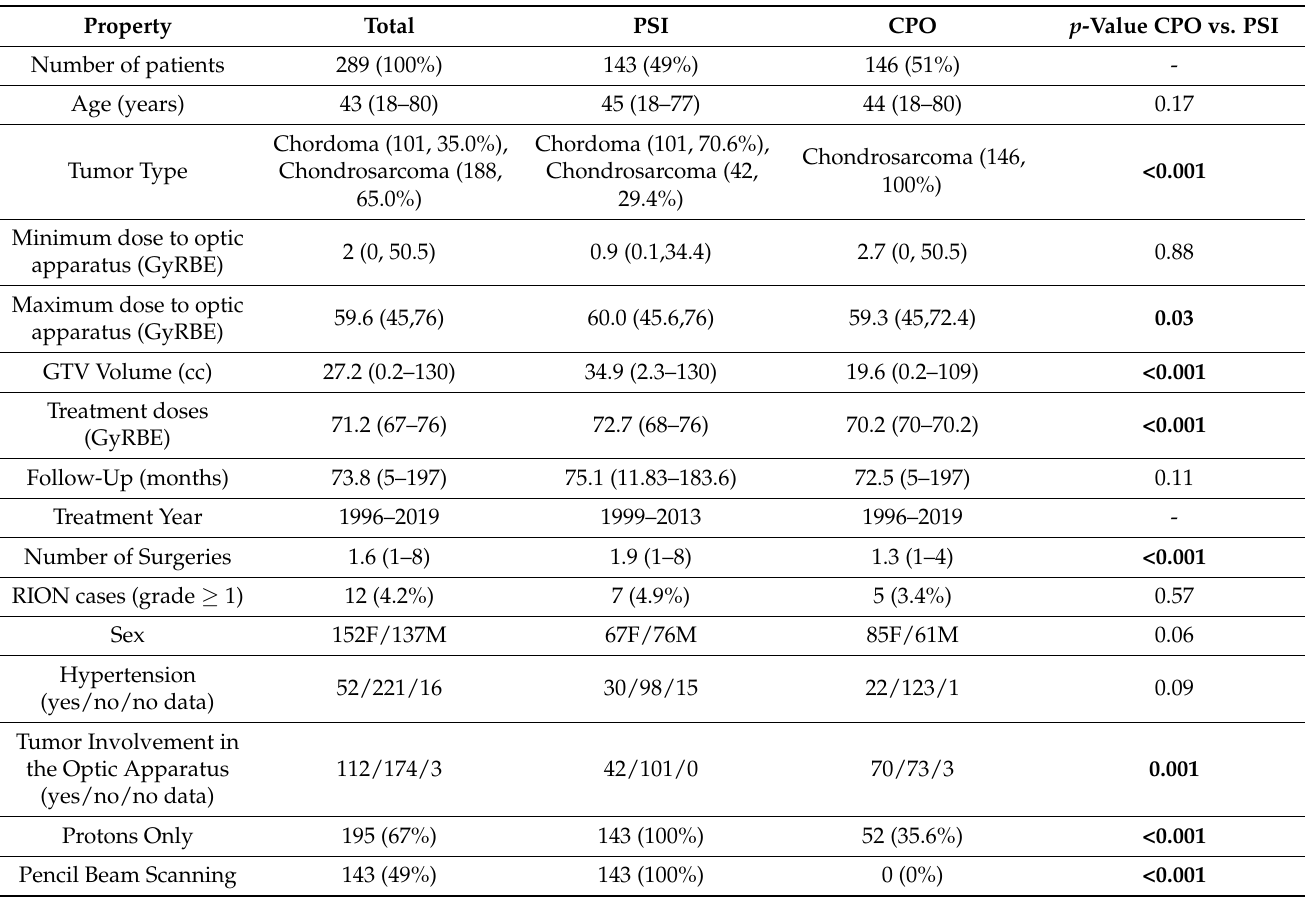
Table 1. Patient characteristics for the combined cohort and the parts from both institutions (PSI, CPO). X (Y-Z) indicates the median (X) and the range for this variable (Y-Z). A statistical comparison between the parts of each cohort was performed. A p -value is computed based on a Wilcoxon rank sum test for continuous and a Fisher’s exact test for categorical variables. p -values below 0.05 (bold) are considered to show significant differences between the institute